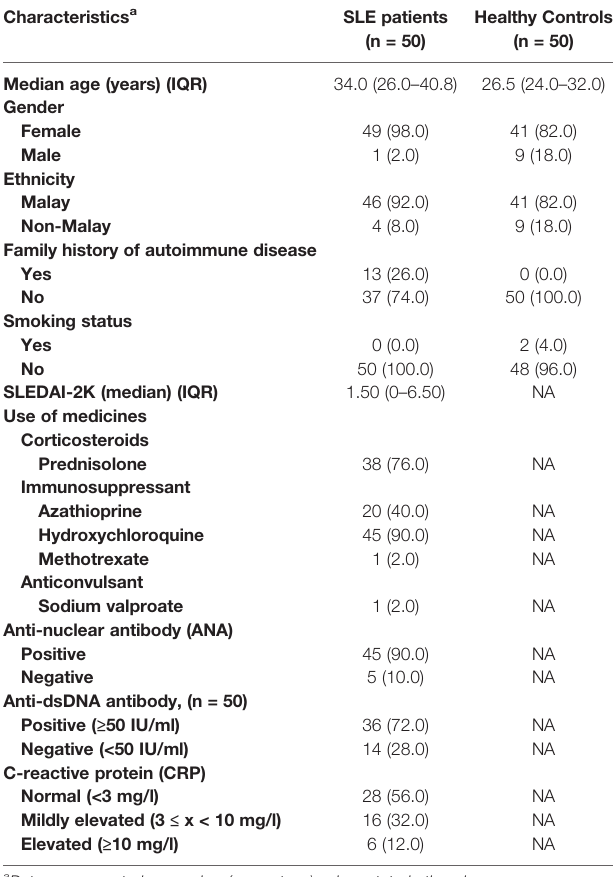
TABLE 1 | Clinico-demographical and immunological characteristics of SLE patients and healthy controls. Characteristics